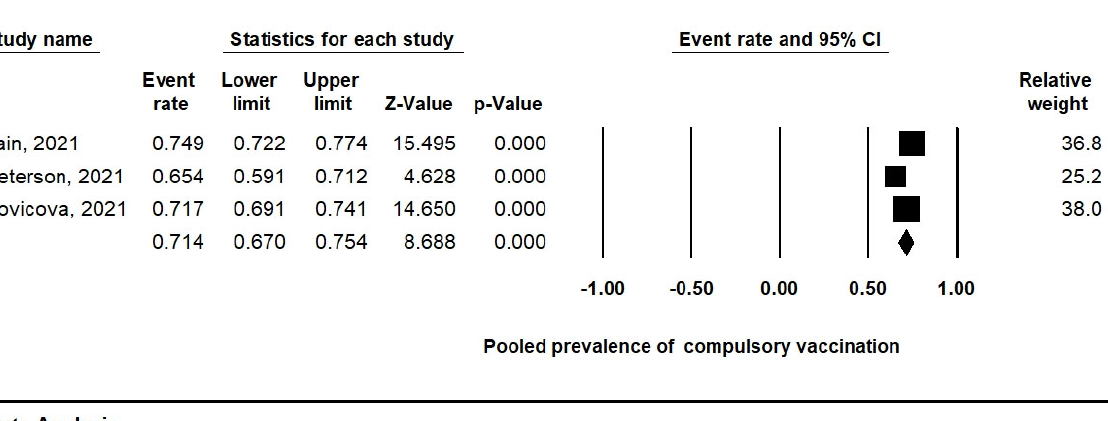
Figure 5. Forest plot representing the relationship between vaccination acceptance and attitudes towards compulsory vaccination of HCWs.